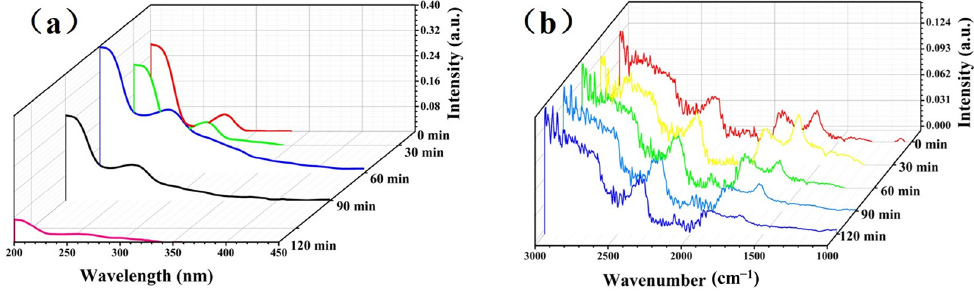
Figure 9. UV-Vis absorbance spectra ( a ), in situ DRIFTS ( b ) of phenol degradation over non-stacked γ -Fe 2 O 3 /C@TiO 2 .